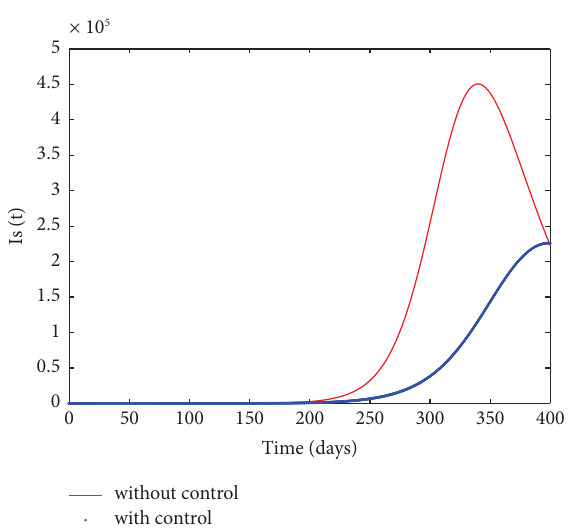
Figure 19: Behaviour of the symptomatic individuals with and without the control.